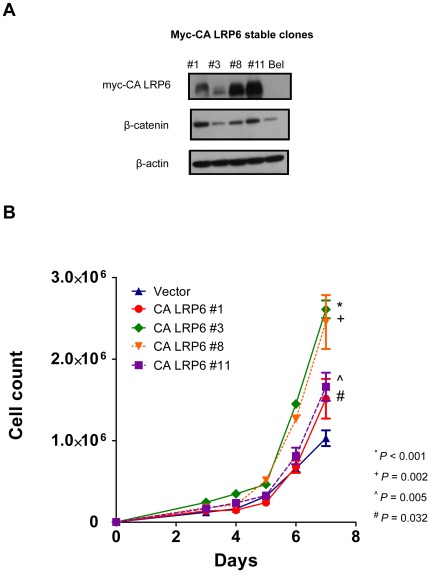
Constitutively active LRP6 enhanced cell proliferation in vitro.
(A) LRP6 expressing BEL-7402 stable cells were established using myc-CA LRP6 construct. The protein level of β-catenin was upregulated as compared with the parental BEL-7402 cells. (B) Cell proliferation assay. The numbers of cells of CA LRP6 Clones #1, #3, #8 and #11 on Day 7 were significantly higher than the vector control BEL-7402 cells (P = 0.032, <0.001,  = 0.002 and 0.005, respectively).